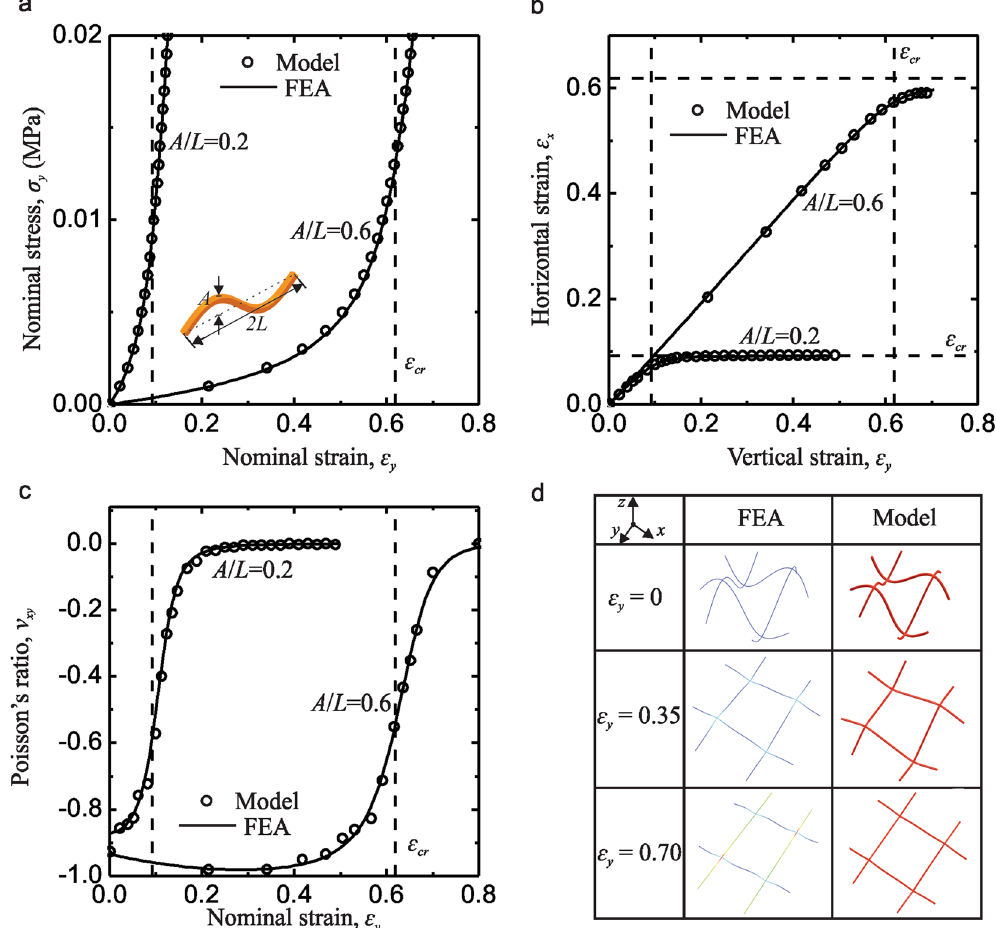
Figure 4. Theoretical and FEA results of 3D planar auxetic metamaterials under uniaxial tensile tests: ( a ) nominal stress vs. nominal strain curve; ( b ) measured horizontal strain vs. vertical strain; ( c ) calculated incremental Poisson’s ratio curves as a function of nominal strain; ( d ) Theoretical and ( e ) simulation images for the specimen with A / L = 0.6 at different levels of macroscopic strain: 0, 0.35, and 0.7. Here the dash lines present the critical strain which is the strain to fully extend the curved beam with sine